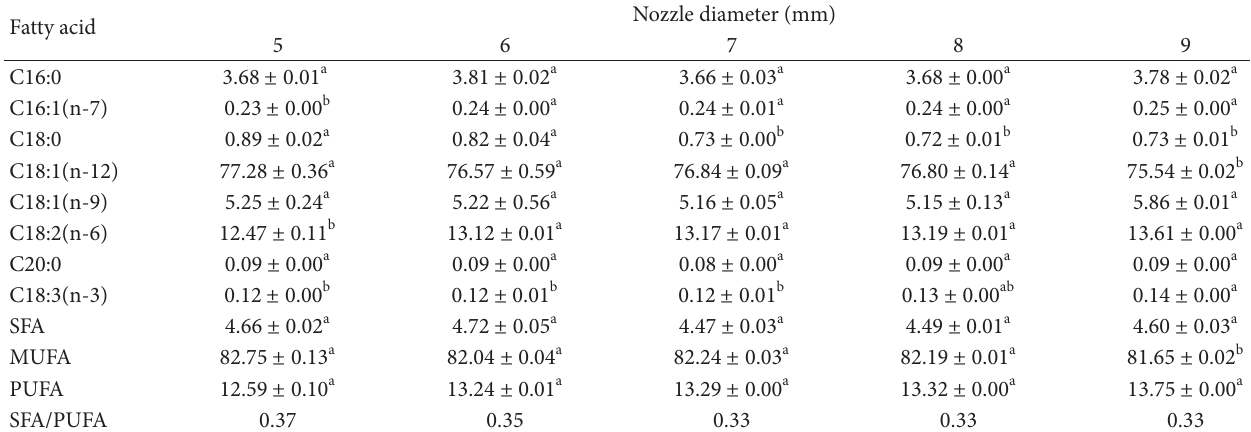
T 1: Effect of nozzle diameter on fatty acid composition (